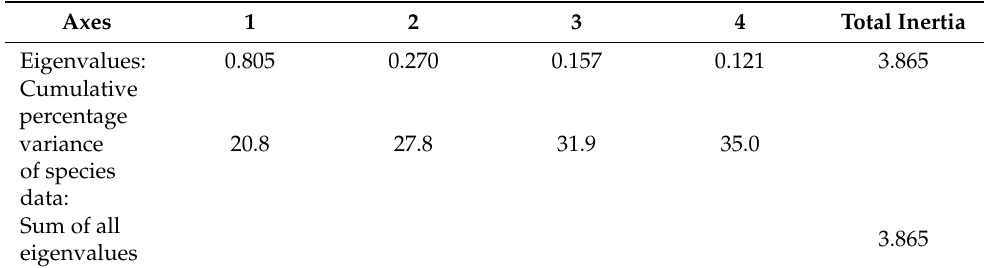
Table 3. Summary of DCA results for all samples and all